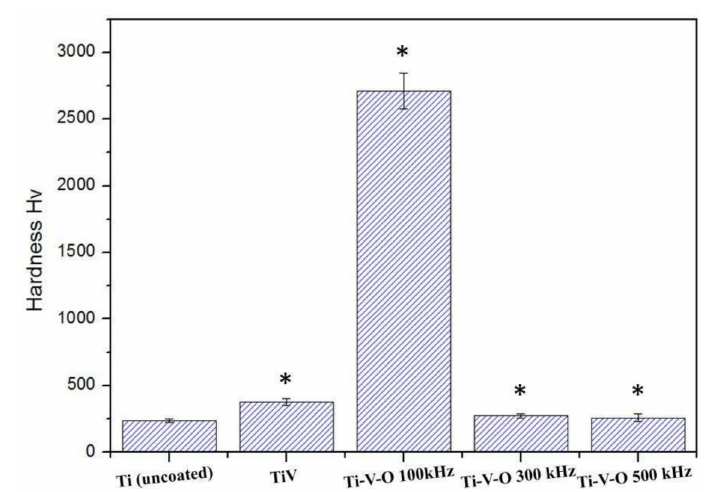
Figure 5. Vickers hardness test results of the uncoated Ti, TiV coating, and LSTO Ti-V-O coating samples. * Significantly different from the control group—uncoated Ti plate ( p < 0.01).